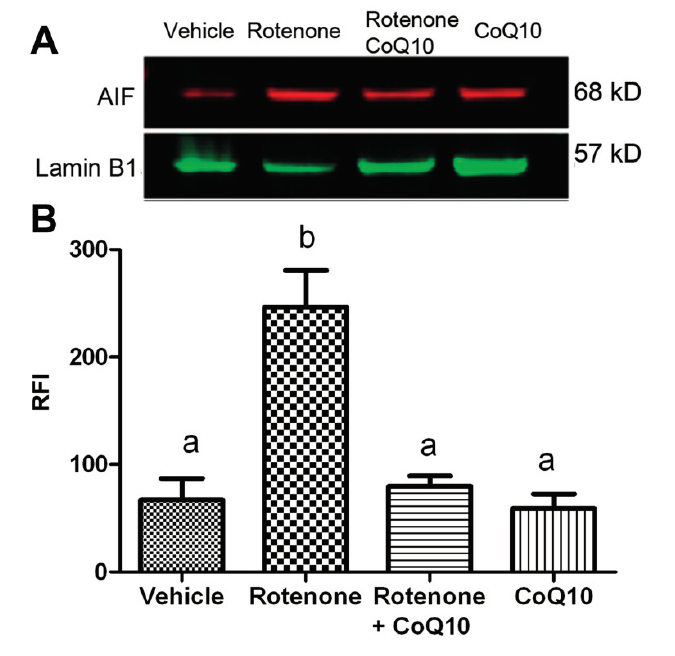
Figure 5. AIF protein levels in the nuclear fractions. ( A ) a representative Western blot showing AIF levels in the nuclear fractions. Lamin B1 served as internal protein loading control; ( B ) a bar graph showing semiquantitative band intensity ratio between AIF and lamin B1. Data were collected from 3 independent experiments and presented as means ± s.d. Groups with same letter labeled on the top indicate no significant difference while groups with different letter suggest a statistical significance when compared among the groups ( p < 0.01 a vs. b).